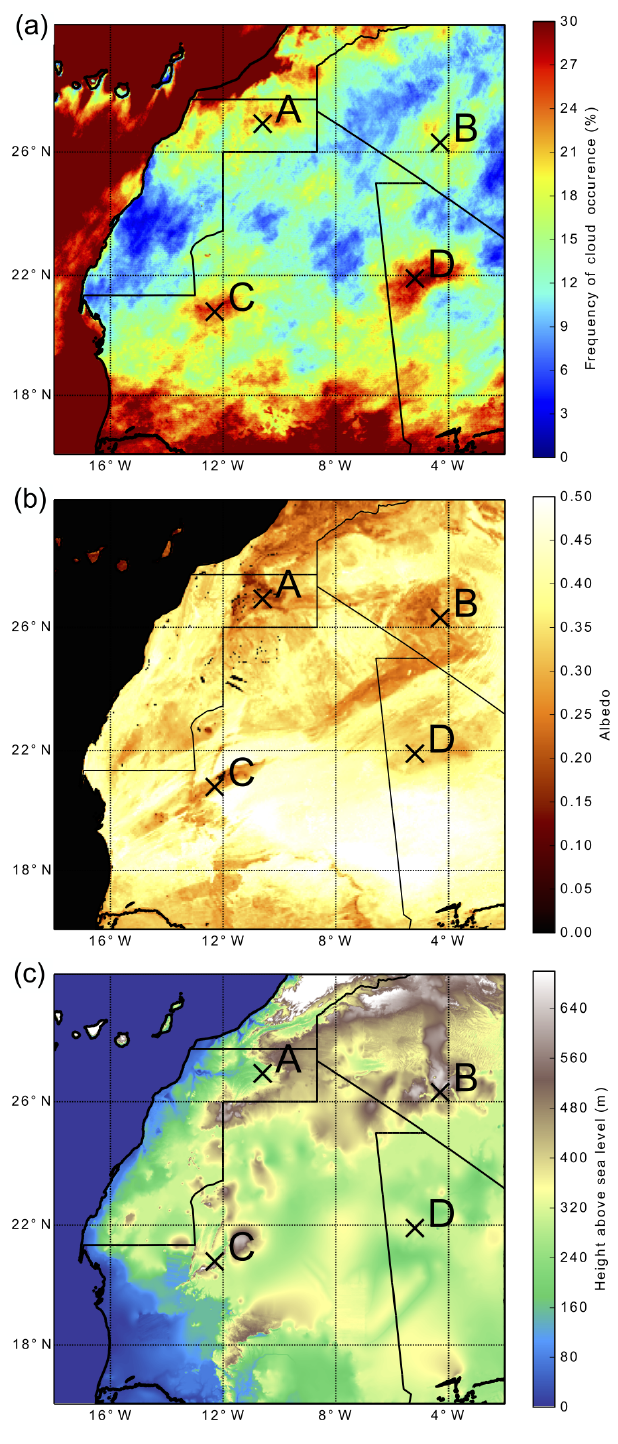
Figure 9. (a) Compilation of all cloudy SEVIRI pixels (CloudRetrieval mask) across all the Fennec BAe146 flight dates. Lettering (A–D) indicates the cloudiest land-based areas in the re- gion of interest. Image compiled from 670 SEVIRI CloudRetrieval cloud mask frames in the daytime for June 2011 and 2012 (simul- taneous to research flight times only) (b) Surface albedo map of the region. (c) Terrain map of the